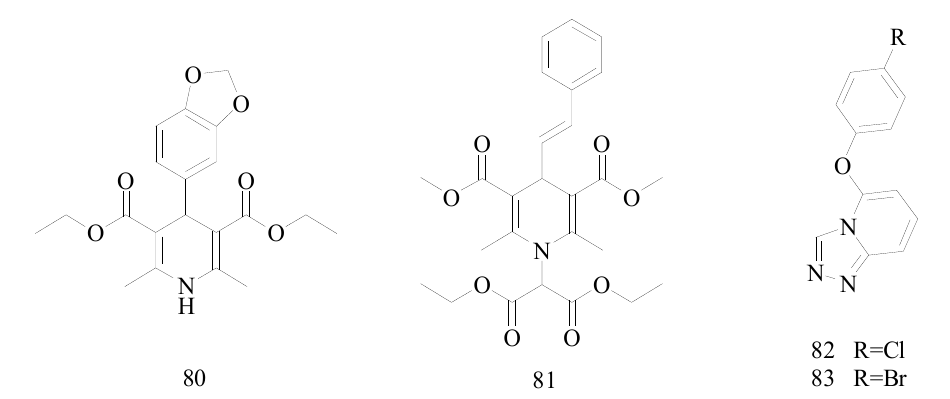
Figure 4. Structures of compounds 80 – 83 .